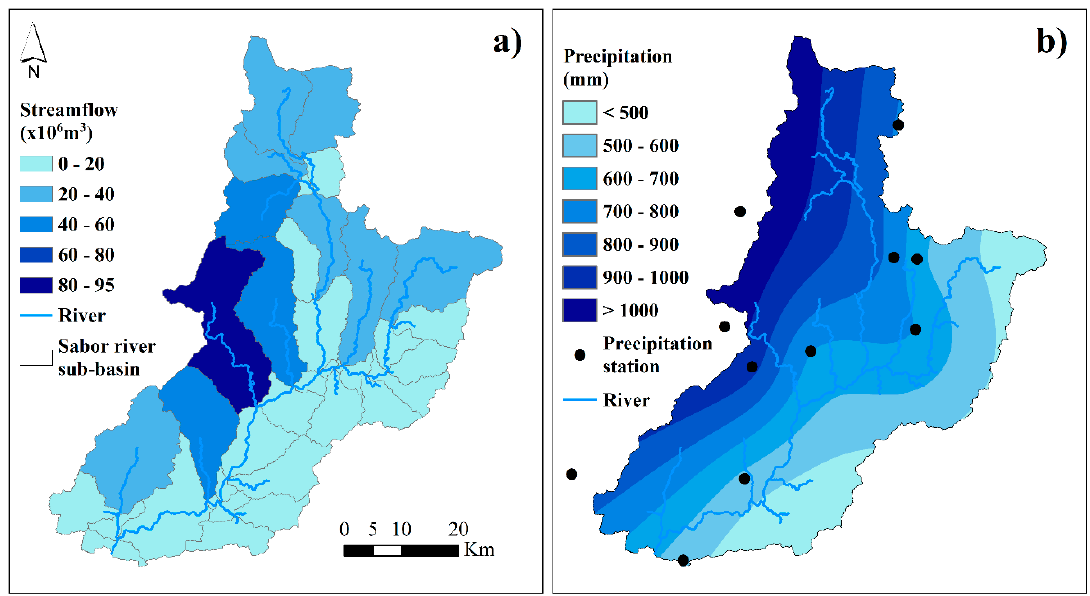
Figure 6. The streamflow and precipitation in the Sabor River basin. ( a ) The streamflow is an annual average value for the period 1960–2008 and is represented at the sub-basin scale. ( b ) The precipitation is based on the spatial interpolation of data from the meteorological stations used in SWAT to construct the hydrological model, with values for the period